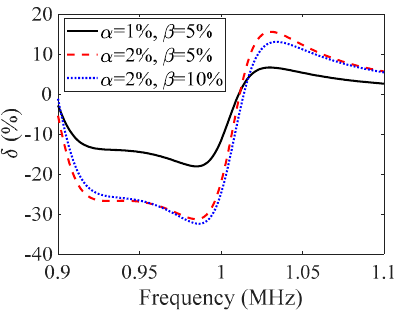
Figure 7. δ changes with λ under different values of α and β .